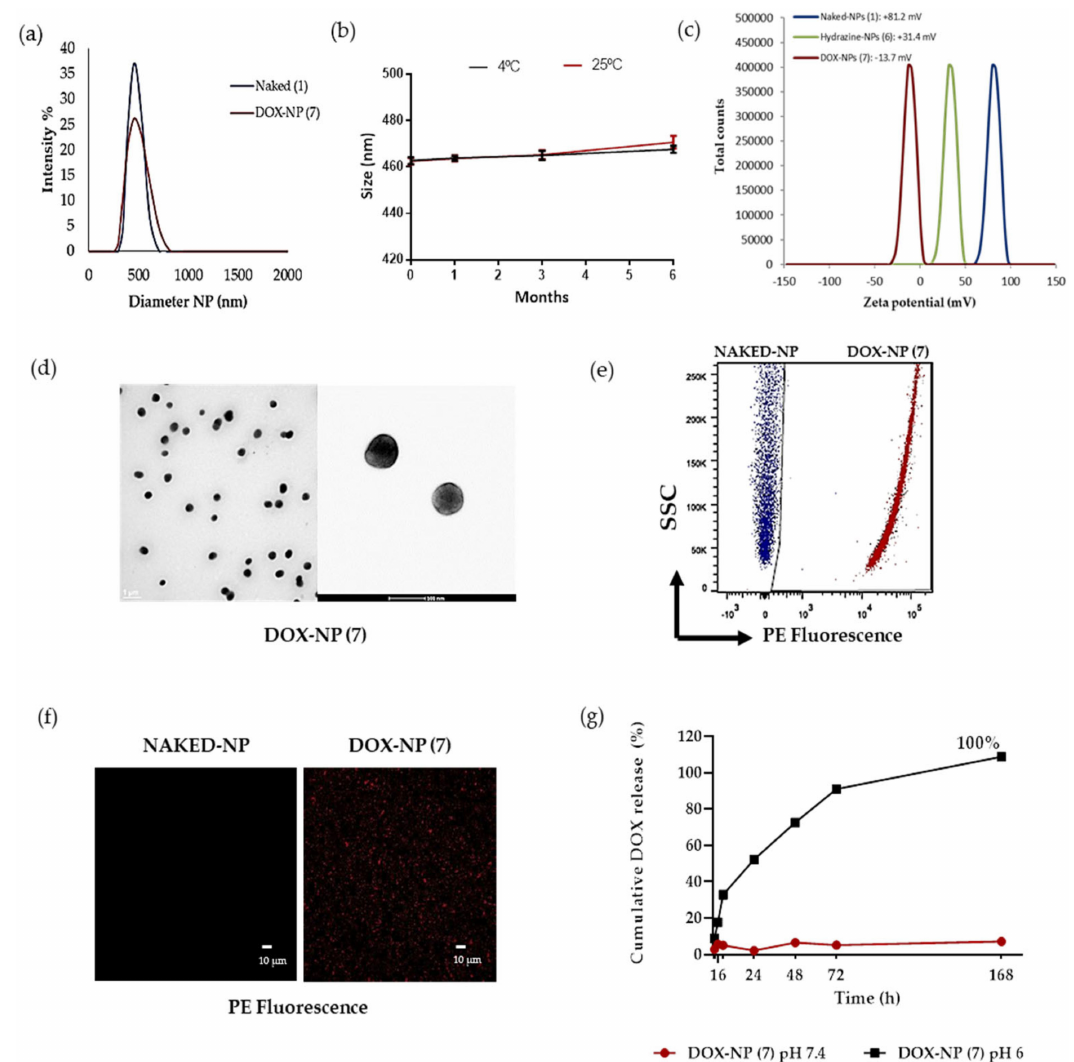
Figure 1. Characterization of the DOX-NPs ( 7 ). ( a ) Hydrodynamic diameter of DOX-NPs ( 7 ) versus Naked-NPs ( 1 ); ( b ) Stability of DOX-NPs ( 7 ) for six months at 4 ◦ C and 25 ◦ C; ( c ) Values of the zeta potential of DOX-NPs ( 7 ) (red) versus Hydrazine-NPs ( 6 ) (green) and NAKED-NPs ( 1 ) (blue); ( d ) Transmission electron microscopy (TEM) analysis; ( e ) Dot plots representative of flow cytometry of NAKED-NPs ( 1 ) (blue) and DOX-NPs ( 7 ) (red); ( f ) Images of confocal laser microscopy of naked nanoparticles and DOX-NPs ( 7 ). Images with an increase of 63x show the signal of red channel. Scale bar, 10 µ msignal of red channel. Scale bar, 10 µ m. ( g ) Cumulative DOX Release. DOX-NPs ( 7 ) were incubated in phosphate solution at pH 6 and PBS at pH 7.4 for 168 h at 37 ◦ C.The results are expressed with the values of the mean ±